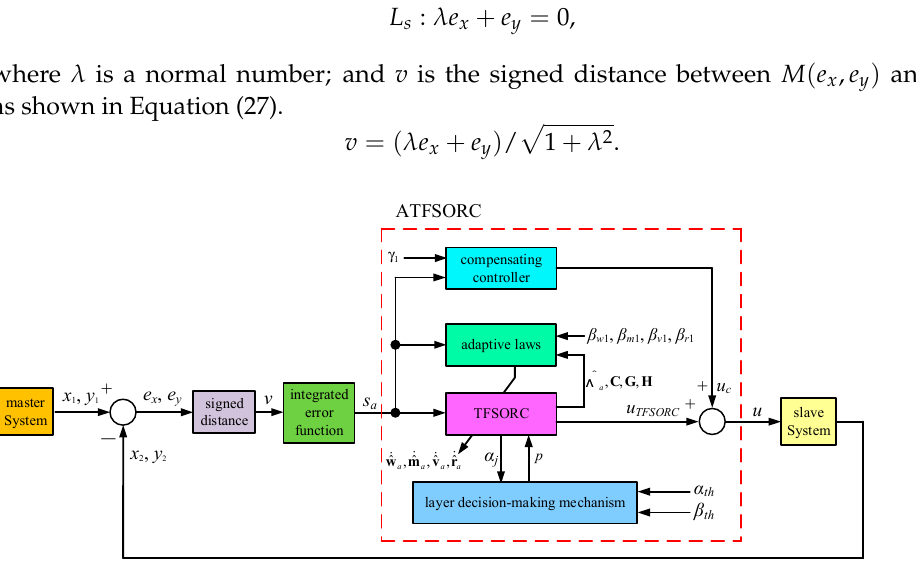
v . Figure 7 shows the e x − e y plane and the switch line L S , which is as shown in Equation (26).